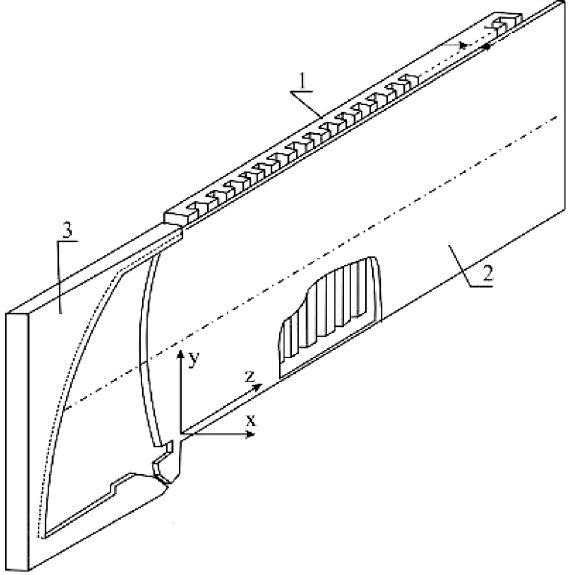
Fig. 2. The transceiver antenna: 1 – diffraction grating, 2 – planar dielectric waveguide, and 3 – parabolic horn feed